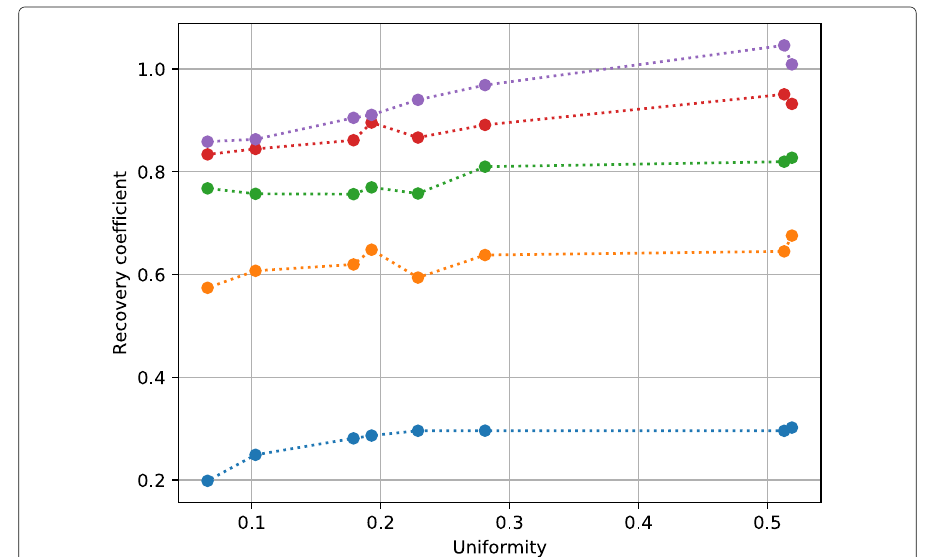
Fig. 7 Measured recovery coefficients as a function of uniformity. The curves of the recovery coefficients correspond to rods with diameters of 5 to 1mm, from top to bottom. Each different uniformity value corresponds to a different filter width used during reconstruction. A larger filter reduces variance and therefore increases uniformity (i.e., decreasing relative standard deviation). The recovery coefficients are increasing with increasing uniformity values, so overall image quality performance is a trade-off between uniformity and